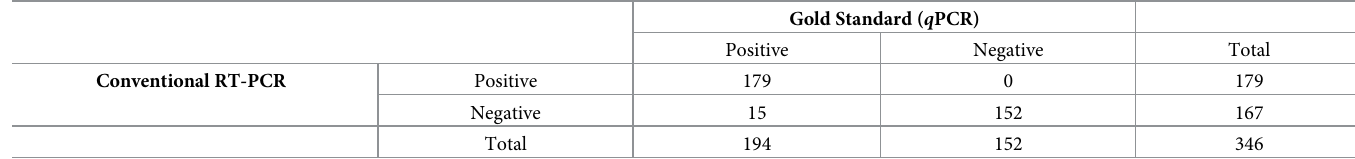
Table 1. Comparison between the results of samples processed by qPCR and samples processed by conventional RT-PCR.